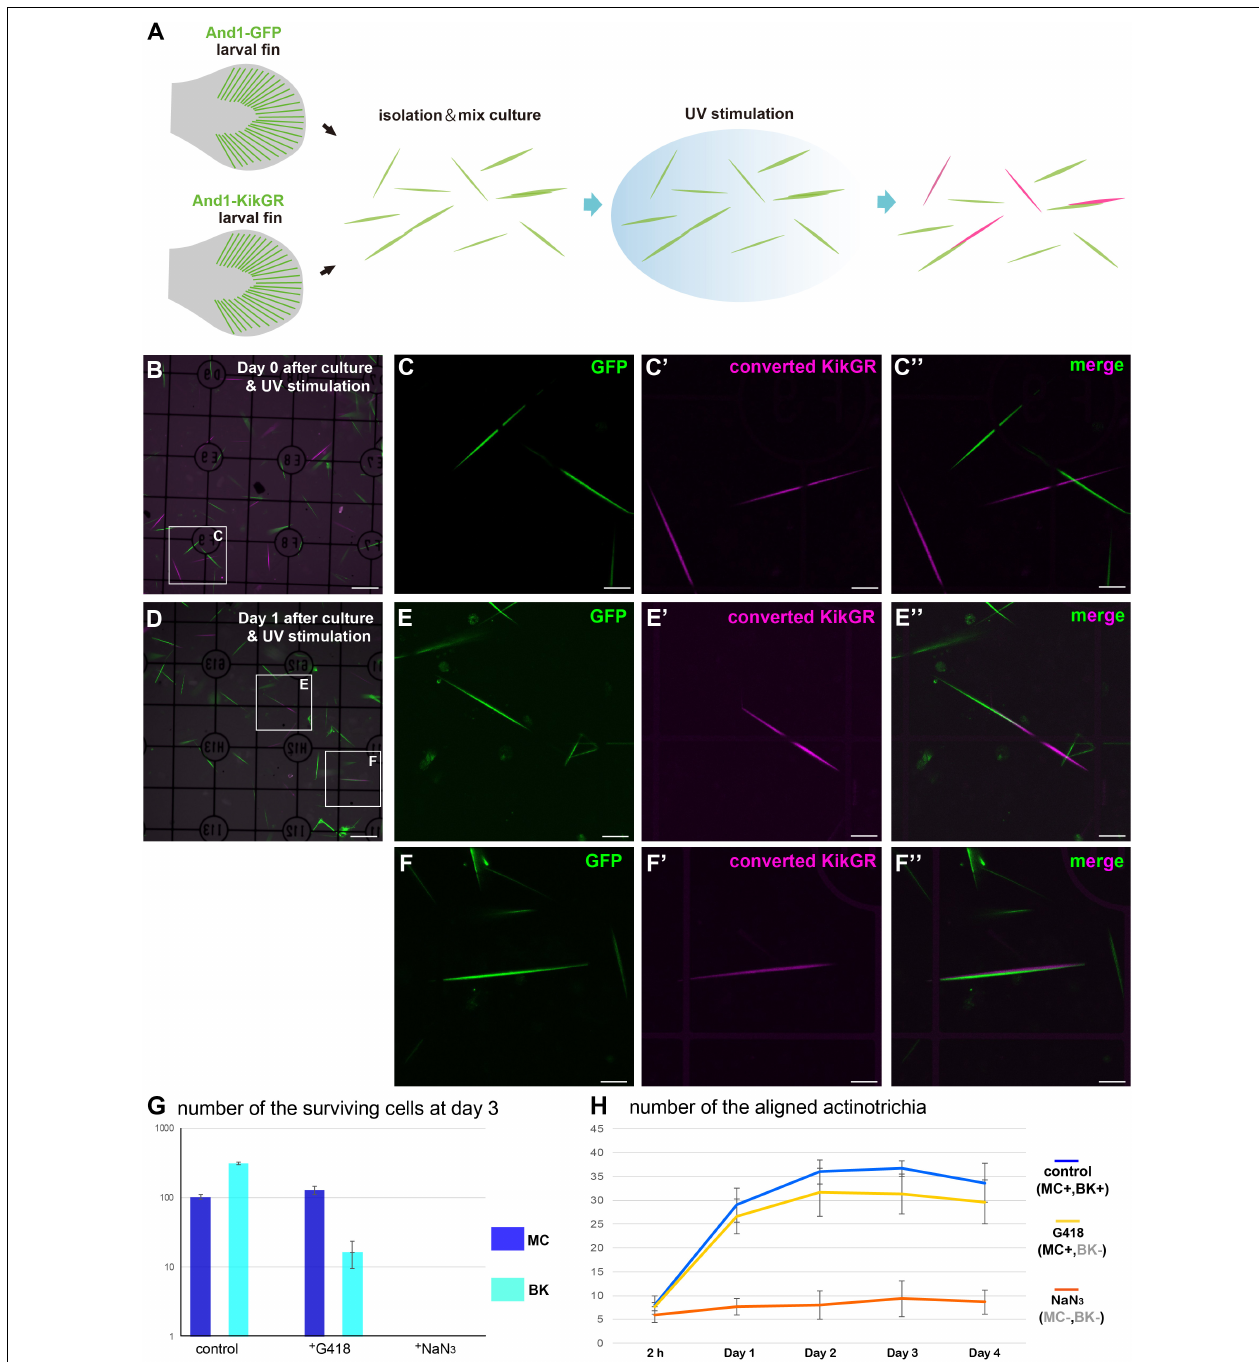
FIGURE 5 | Mesenchymal cells are essential for the in vitro alignment of actinotrichia. (A) Illustration of the procedure for the in vitro mix culture experiment. Actinotrichia and cells were harvested from two different TG larval fins (TG; and1 1.4k: And1-GFP, and1 1.4k: And1-KikGR) and cultured on a Matrigel-coated dish. The isolated actinotrichia were stimulated by UV radiation in vitro and the aligned actinotrichia composed of fibrils labeled by two different fluorescent proteins were counted. (B) The fluorescence image at Day 0 (after 2 h of culture and UV stimulation). (C–C (cid:48)(cid:48) ) Magnified images of the white box in (B) . (D) The fluorescence image at Day 1 after culture and UV stimulation. (E–E (cid:48)(cid:48) ) Magnified images of the white box in (D) . Two actinotrichia were connected tip-to-tip and their orientation was aligned. (F–F (cid:48)(cid:48) ) Magnified images of the white box in (D) . Two actinotrichia were connected with side-to-side and their orientation was aligned. (G) Number of the surviving mesenchymal cells and basal keratinocytes under the control, G418 (200 µ g/ml)-treated condition and NaN 3 (0.1%)-treated condition. (H) The aligned actinotrichia were increased in the G418-treated condition (only mesenchymal cells alive) but not in the NaN 3 -treated condition (cell-free state). MC, mesenchymal cell; BK, basal keratinocyte. Scale bars: 100 µ m in (B,D) , 20 µ m in (C-C (cid:48)(cid:48) ,E-E (cid:48)(cid:48) ,F-F (cid:48)(cid:48) ) .